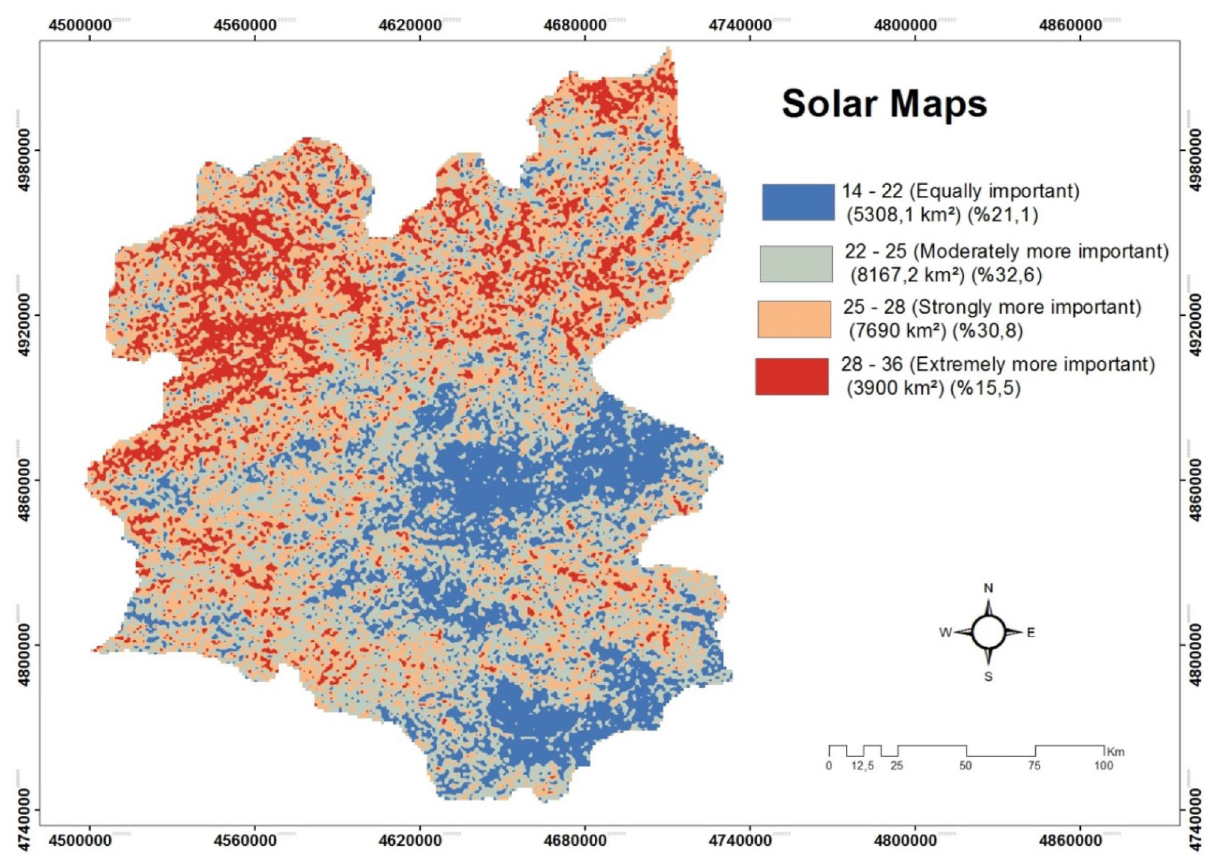
Figure 16. The solar maps of